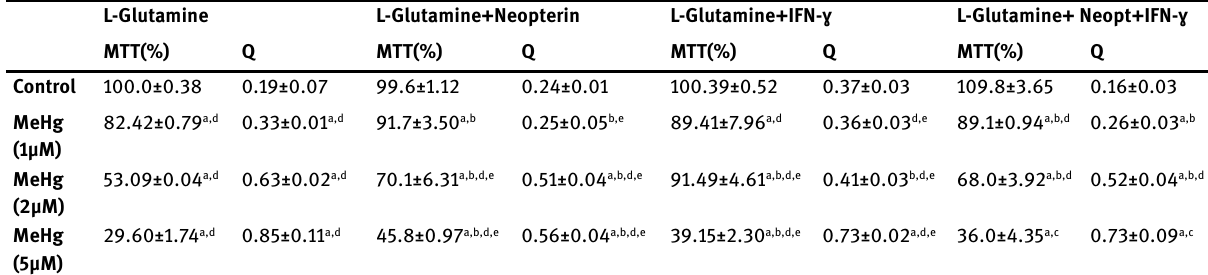
Tables 2: Total mitochondrial metabolic activity and oxidative stress coefficient of MeHg-exposed SH-SY5Y human neuroblastoma cell line at the end of the 48-hour period. ( IFN- ɣ : Interferon-gamma; MeHg: Methyl mecury; MTT: Cell viability; Q: [(NOx/Cc )/(MTT/Cc)], oxidative stress coefficient ).